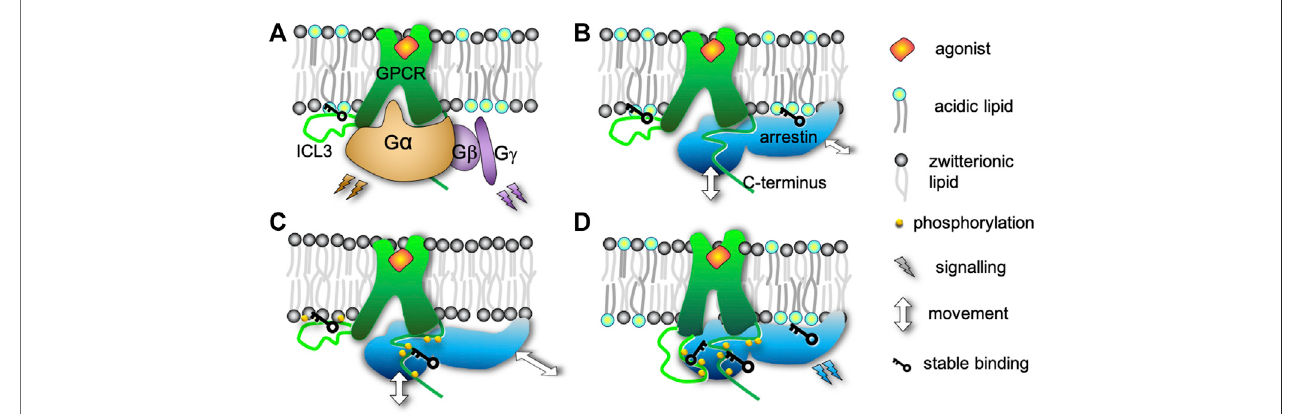
FIGURE5| Effectsoftheinterplayofacidiclipidsandreceptorphosphorylationonthecomplexofadrenaline-activated β 2 -adrenergicreceptorwith β -arrestin2. (A) In the complex of the receptor with a G protein the interactions between ICL3 and acidic lipids cause wide opening of the receptor cytosolic binding pocket enabling bindingofthe α subunitoftheGprotein. (B) SimilarlytoA,thecytosolicbindingpocketiswidelyopenifthereceptorisnotphosphorylatedandembeddedinamembrane withacidiclipids.Consequently,arrestinisnotinsertedasdeeply intothereceptor core.However, theacidic lipidsstillattach arrestintothemembranesurface. (C) Ifthe receptor isphosphorylatedbut embedded inamembranelackingacidic lipids, theICL3 bindstothemembrane and widelyopens the cytosolic pocket. In contrast to B, the lack of acidic lipids causes looser interactions between arrestin and the membrane increasing the rotational fl exibility of arrestin relative to the receptor. The phosphorylated C-terminus attaches fi rmly to the arrestin. (D) The presence of both phosphorylation and acidic lipids causes the complex to be the most compact by three mechanisms. (i) ICL3 interacts with the arrestin instead of the membrane. The lack of ICL3 interactions with the membrane makes the cytosolic binding pocket smallerandenablestighterinteractionwitharrestin.(ii)ThephosphorylatedC-terminusbindstotheN-lobeofarrestinand(iii)acidiclipidsattacharrestintothemembrane surface. Thus, the conformation and dynamics of binding are modulated, which is presumed to steer different intracellular signaling pathways.